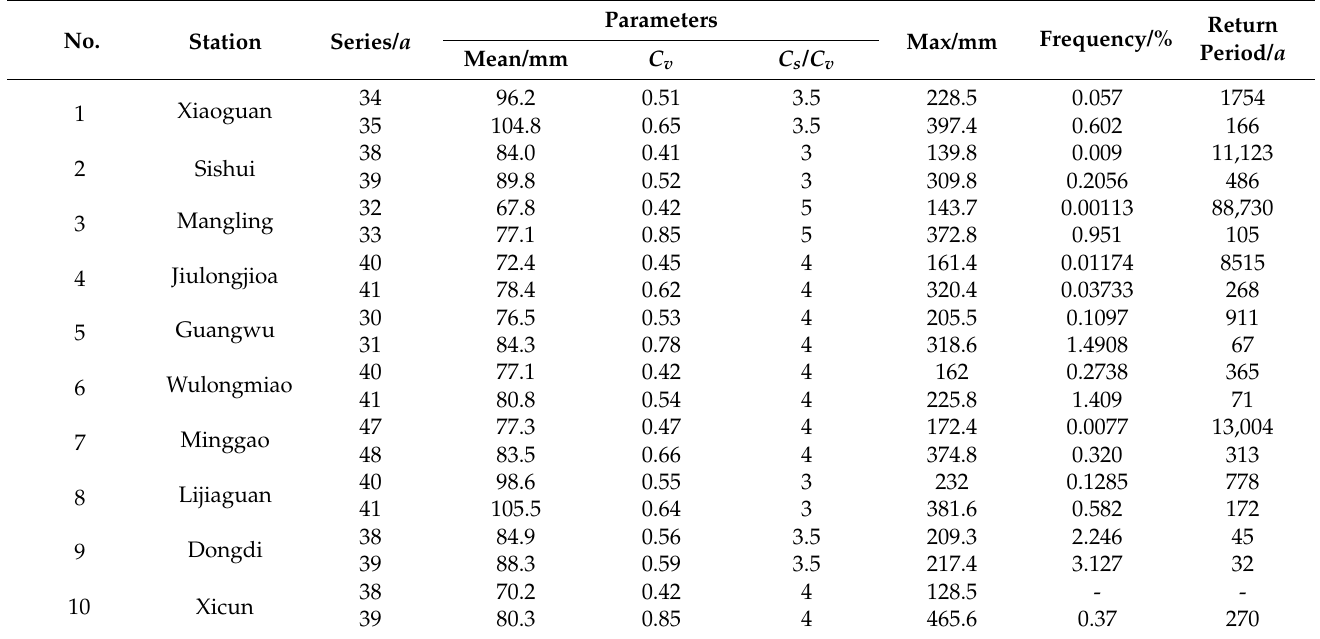
Figure 8. The frequency curve of the maximum 24 h rainfall of discontinuous 41 years in 1978~2021 at Wulongmiao station. Table 3. Frequency analysis parameters and return period of maximum 24 h rainfall of “7.20” flood in 2021 for reference stations.